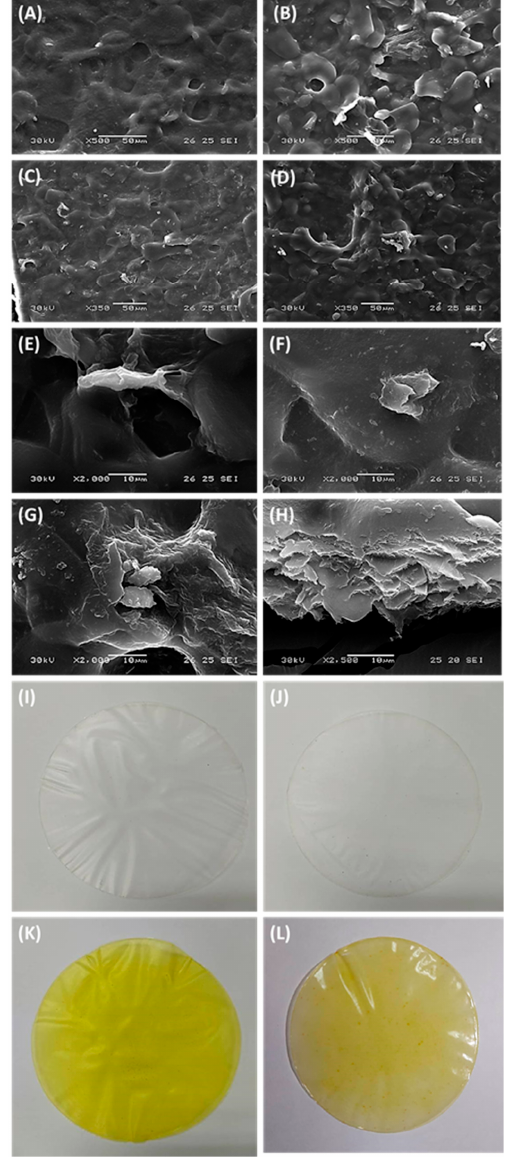
Figure 1. The SEM images of ( A ) banana starch film, ( B ) aloe vera-banana starch film, ( C ) banana starch-curcumin film, and ( D ) aloe vera-banana starch-curcumin film at 50 µ m magnification. The SEM images of the interaction between ( E ) banana starch and aloe vera, ( F ) banana starch and curcumin, and ( G ) aloe vera with banana starch and curcumin at 10 µ m magnification. ( H ) The cross- section image of aloe vera-banana starch-curcumin film at 10 µ m magnification. Surface appearance of ( I ) banana starch film, ( J ) aloe vera-banana starch film, ( K ) banana starch-curcumin film and ( L ) aloe vera-banana starch-curcumin film with a diameter of 90